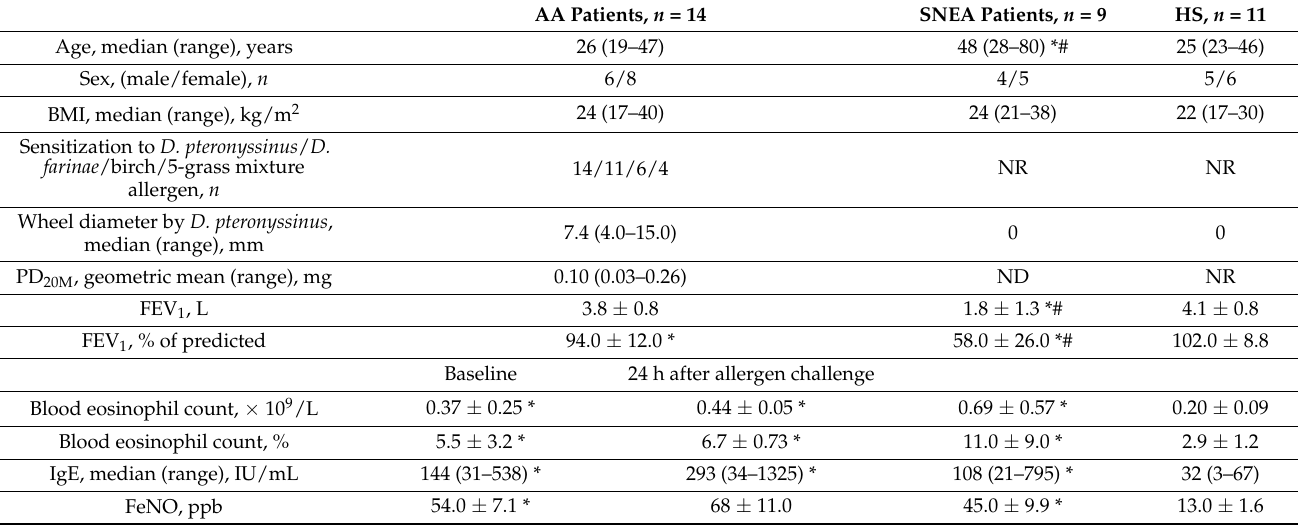
Table 1. Demographic and clinical characteristics of the study